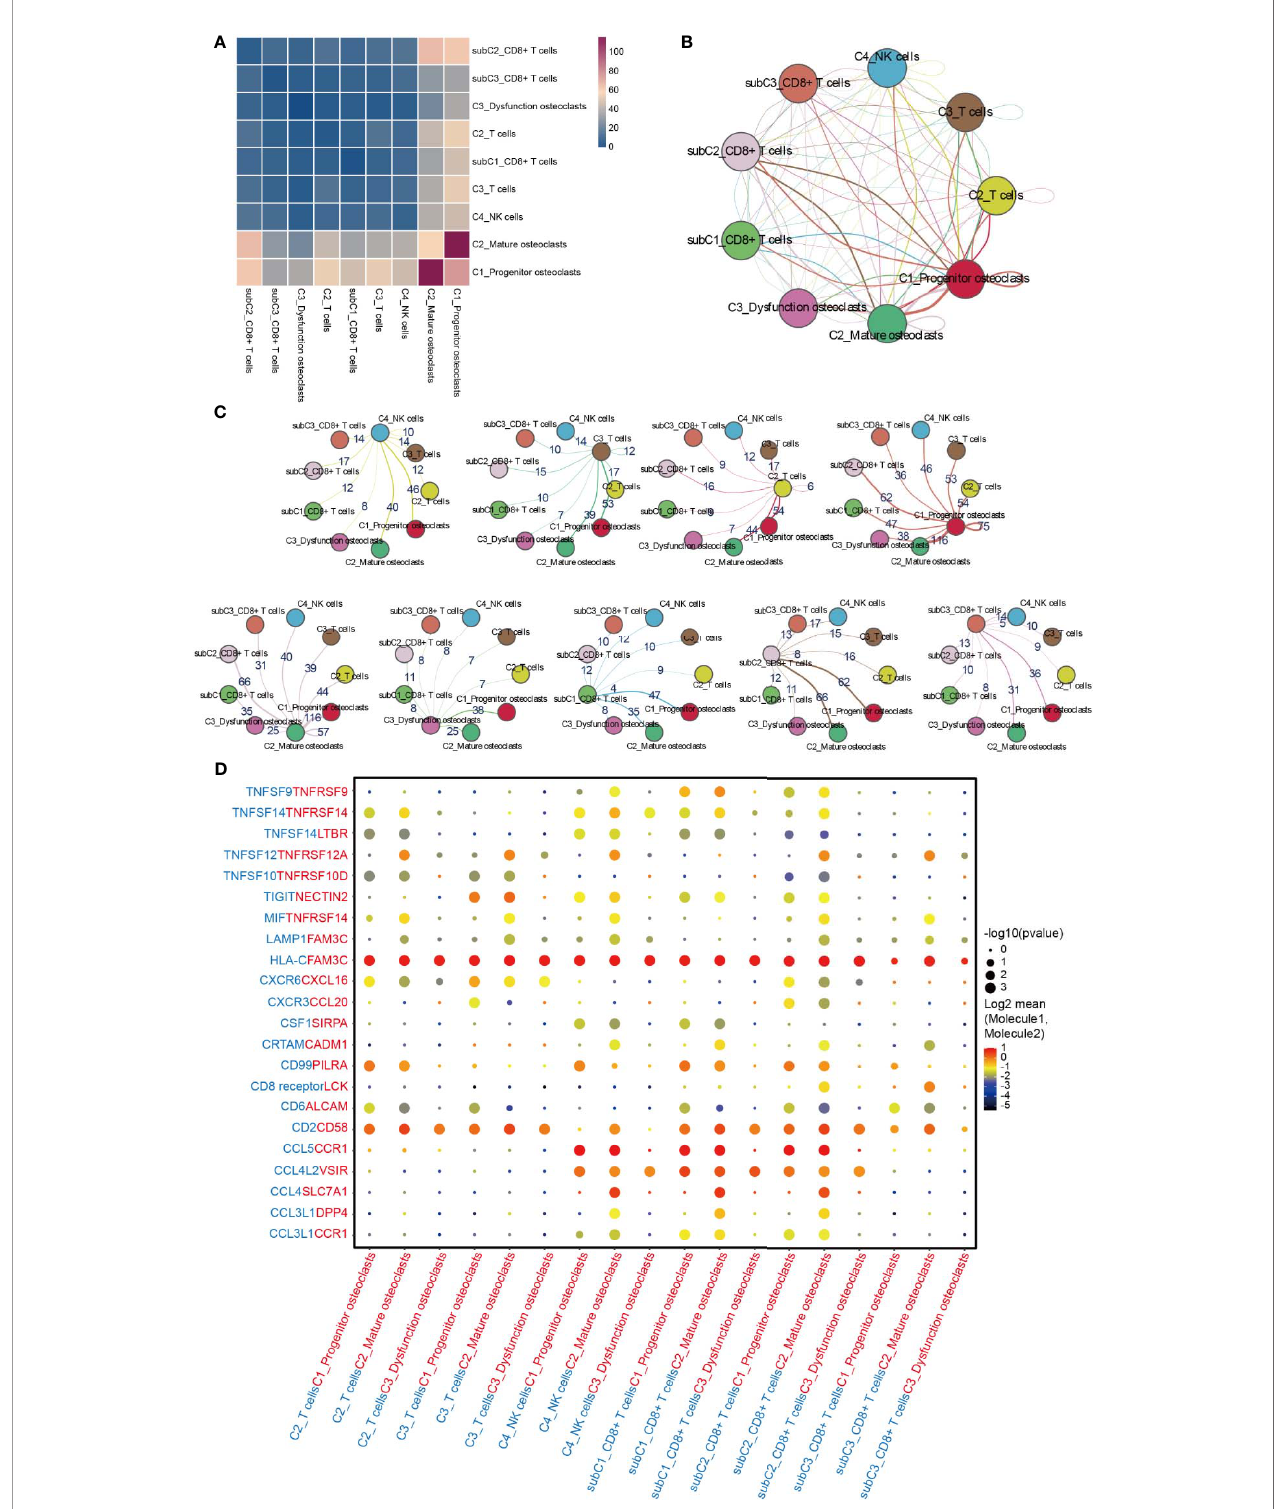
FIGURE 8 | Cell-cell communication network between NK/T cells and osteoclasts in GCTB. (A) Heatmap showing the number of potential ligand-receptor pairs among the selected cell types. (B, C) Interaction network constructed by CellPhoneDB. Thicker lines mean more interaction with other types of cells. (D) Ligand- receptor pairs are shown in the bubble plot. GCTB, giant cell tumor of